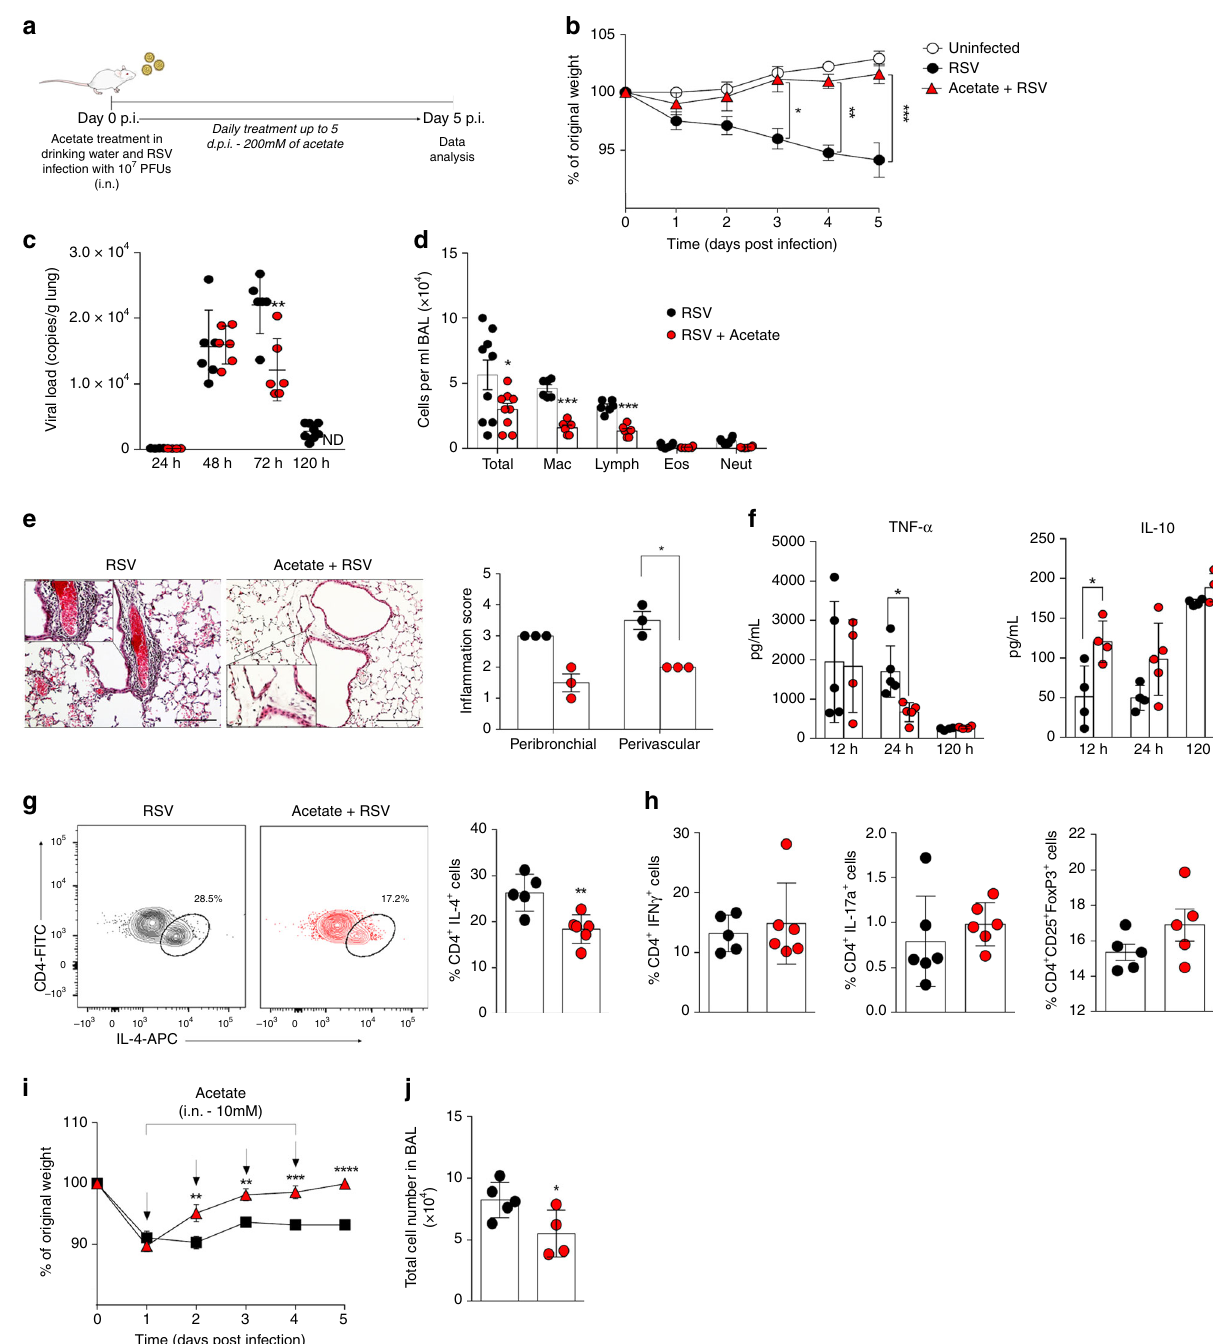
Fig. 4 Acetate treatment protects mice against RSV infection. a BALB/c mice were simultaneously infected with RSV and treated with 200 mM acetate in the drinking water. Analyses were performed on day fi ve post infection. b Percentage body weight loss post infection relative to initial weight (day 0) ( n = 9). c RSV viral load was measured 24, 48, 72, and 120 h after infection detected in lung by real-time PCR (viral copies/g lung tissue) (24, 48, and 72 h, n = 5; 120 h, n = 9). ND = not detected. d Total cell number and differential cell counts in BALF ( n = 9). e Representative images of lung tissue stained with H&E and its respective in fl ammation scores ( n = 3). Scale bars = 100 μ m. f Release of TNF- α and IL-10 in BALF measured at different times after infection ( n = 4). g Percentage CD4 + IL-4 + T cells in lung and its representative FACS pro fi le ( n = 6). h Percentage of IFN γ + , IL-17a + and FoxP3 CD4 T cells in the lung. The representative FACS pro fi les are shown in Supplementary Fig.3 A and B. i , j Female BALB/c mice were infected with RSV (10 7 PFU/ml) and 24 h after infection started the treatment with acetate through the intranasal route (10 mM). Treatment was performed daily up to 5 days after infection. i Percentage body weight loss post infection relative to initial weight (day 0) ( n = 5). j Total cell number in BALF ( n = 5). All data are expressed as mean ± SEM. Data in b , c , d are from two independent experiments. Statistical signi fi cance between the groups was determined by Kruskal – Wallis, except in g , h , j , in which Mann – Whitney was used to compare the groups. * p < 0.05, ** p < 0.01, *** p < 0.001. Data in b , c , d , g , i , j are provided as a